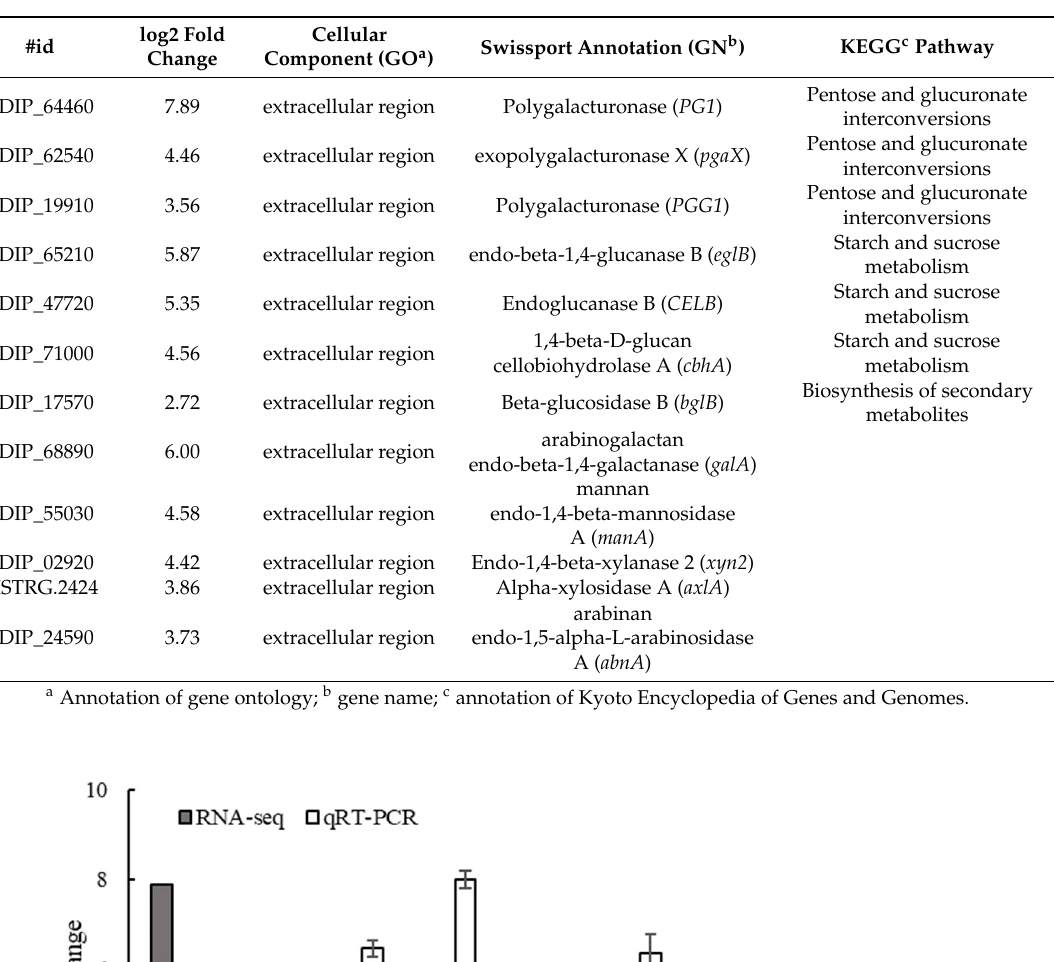
Table 1. Di ff erentially expressed genes related to cell wall degrading enzymes.